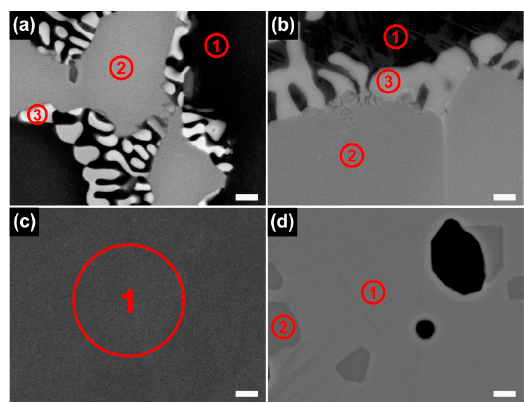
Figure 4. BSE and corresponding EDS mapping images for each group. ( a ) CS; ( b ) ML; ( c ) SLM; and ( d ) ML/PS (500×, scale bar = 50 μ m).